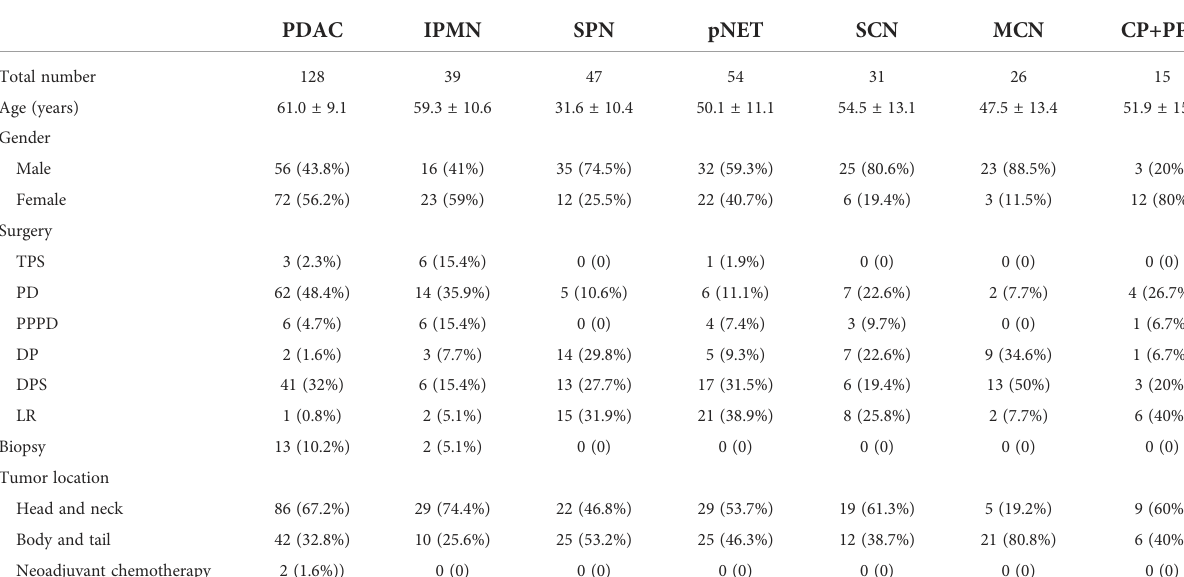
TABLE 1 Basic characteristics of 340 patients with pancreatic